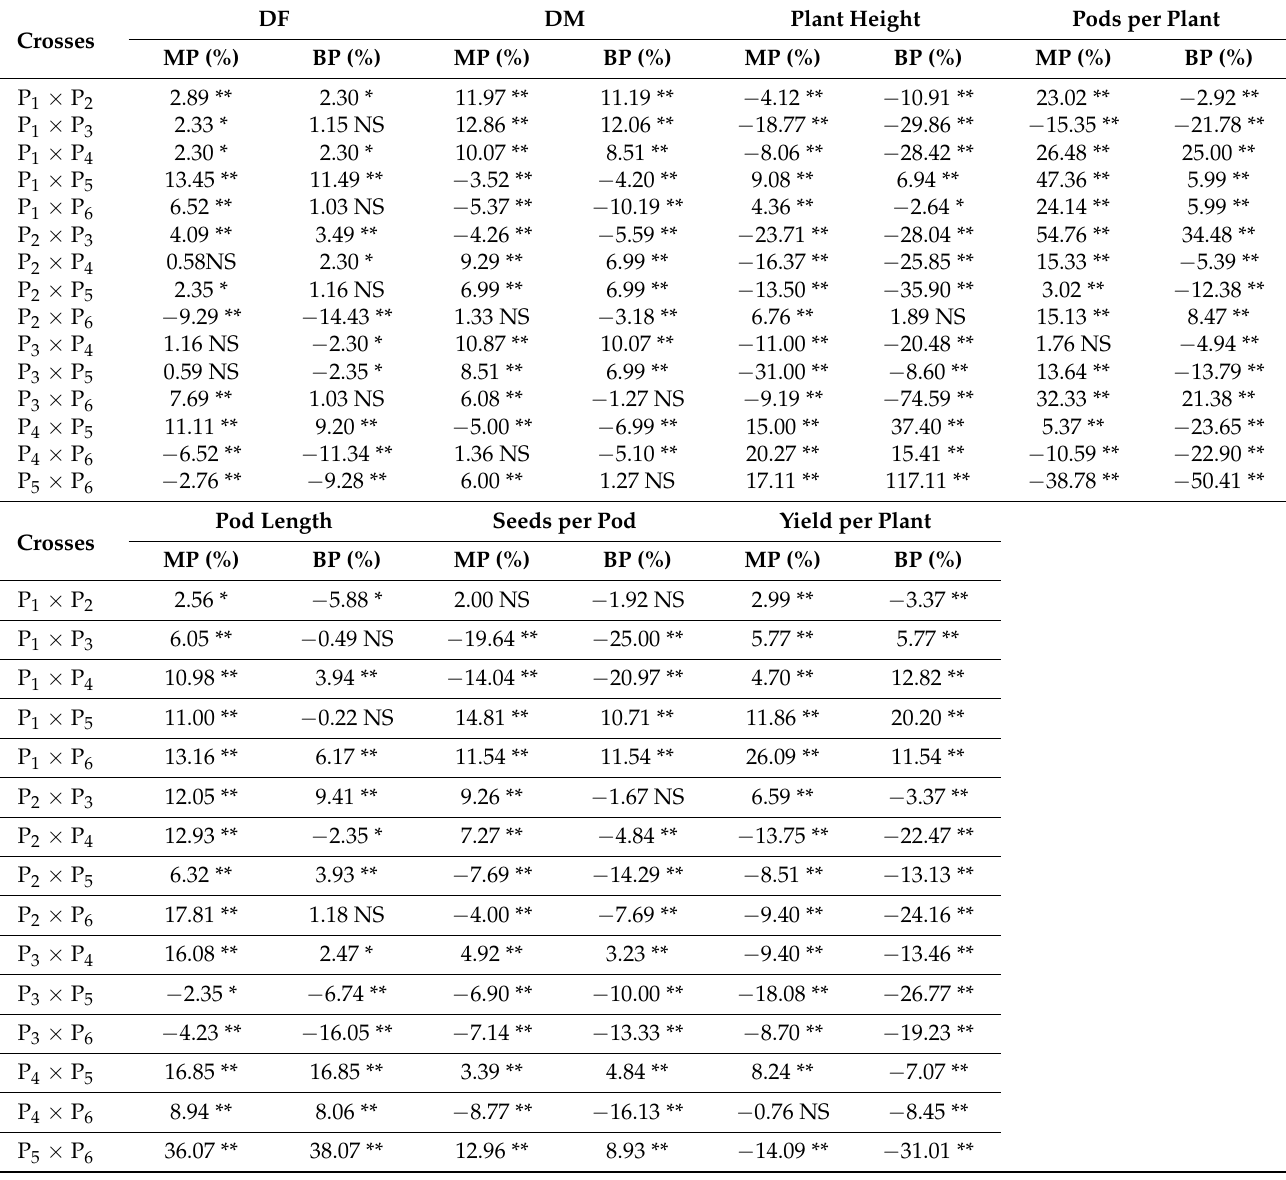
Table 5. Heterosis values (%) over mid-parent and better-parent for important characters of fifteen mungbean